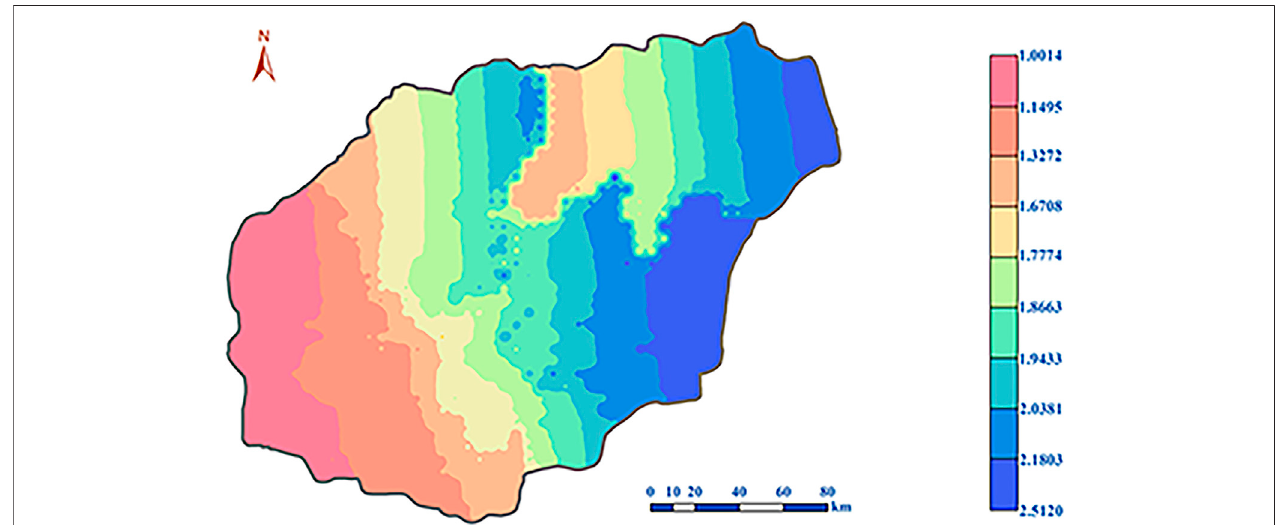
FIGURE 5 | Geospatial environmental in fl uence indicators of tropical forest